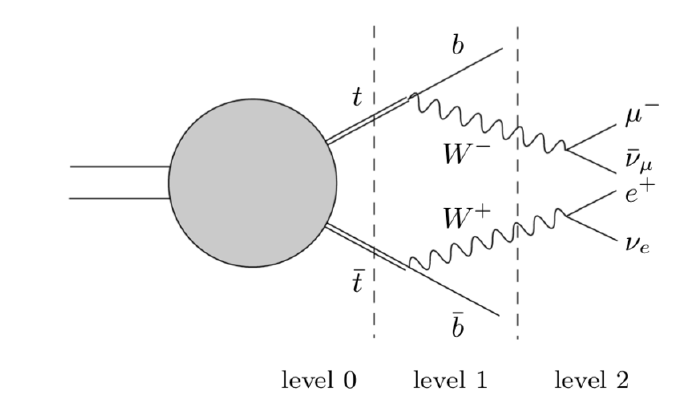
t (cid:22) t b (cid:22) bW + W (cid:0) b (cid:22) be + (cid:23) e (cid:22) (cid:0) (cid:22) (cid:23) (cid:22) ! ! !